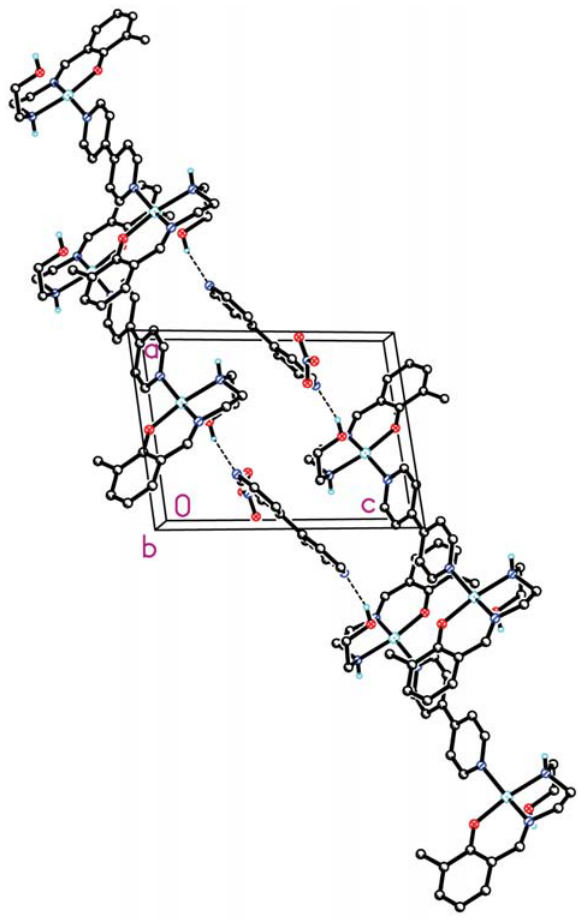
Figure 2. The crystal packing of the complex, viewed along the b axis. Hydrogen bonds are shown as dashed